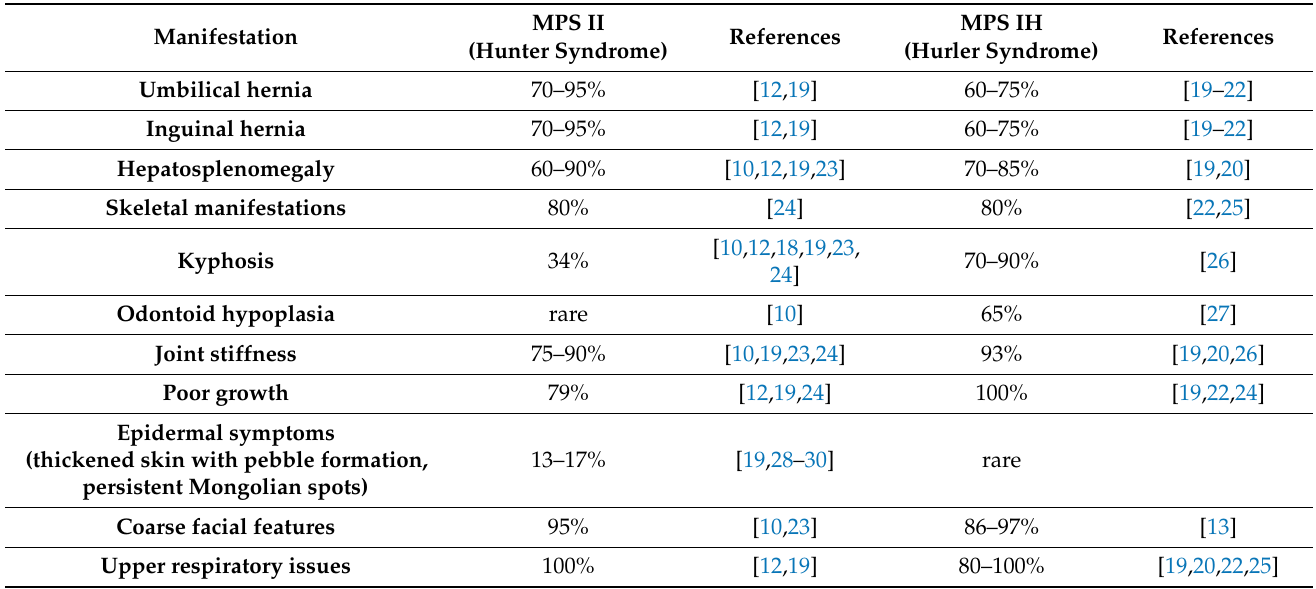
Table 1. Prevalence of clinical manifestations in severe types of MPS II and MPS IH in the absence of therapy.